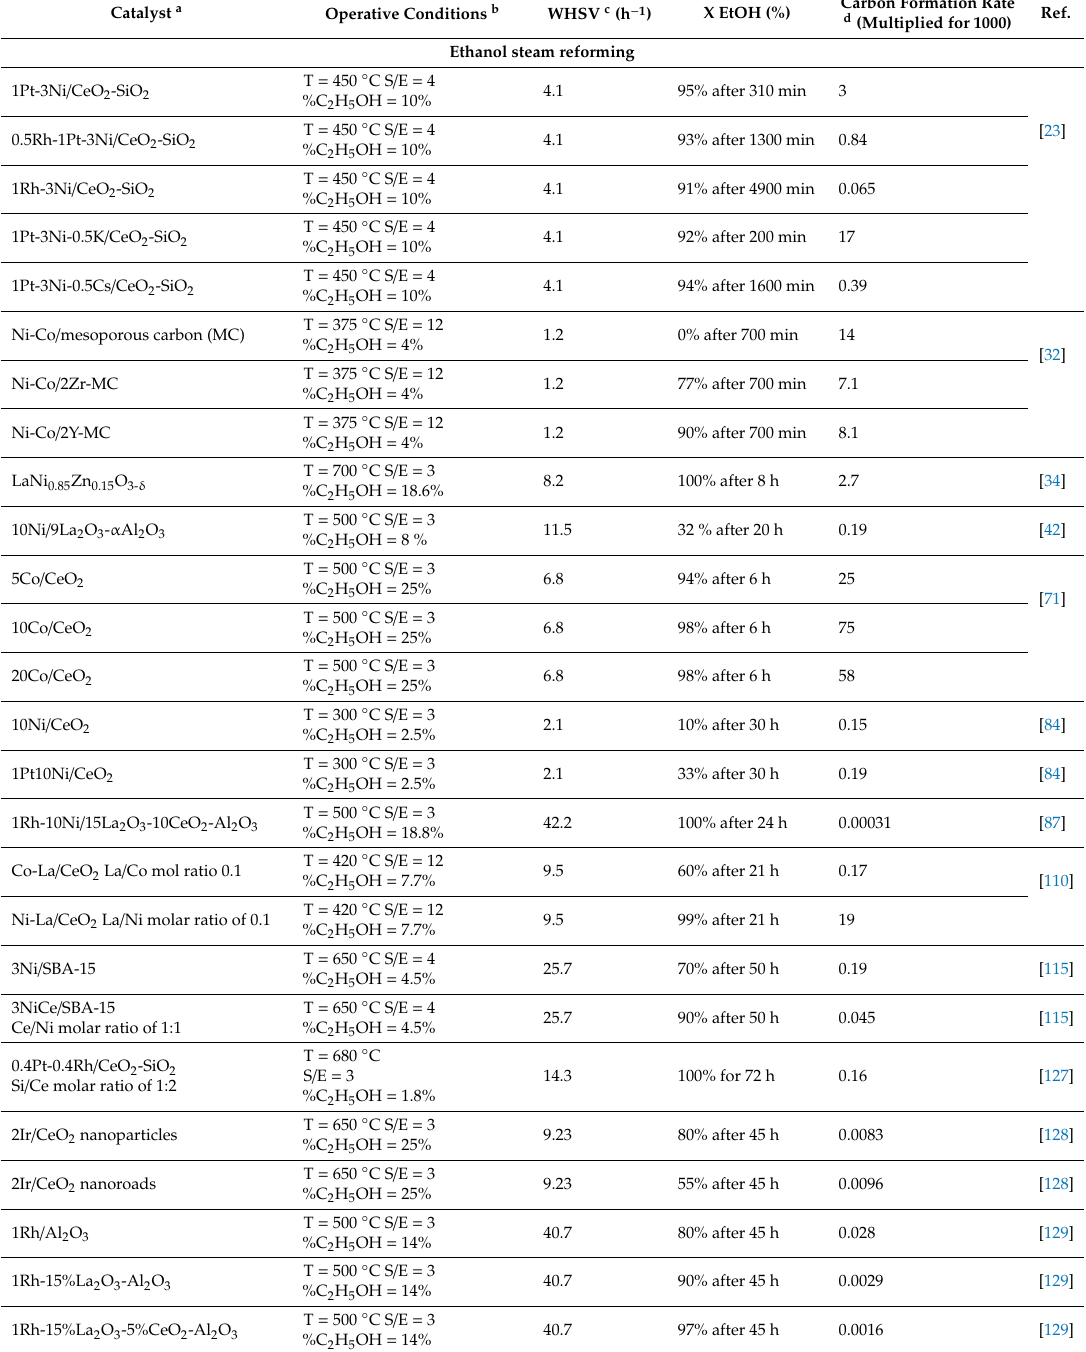
(Multiplied for 1000)